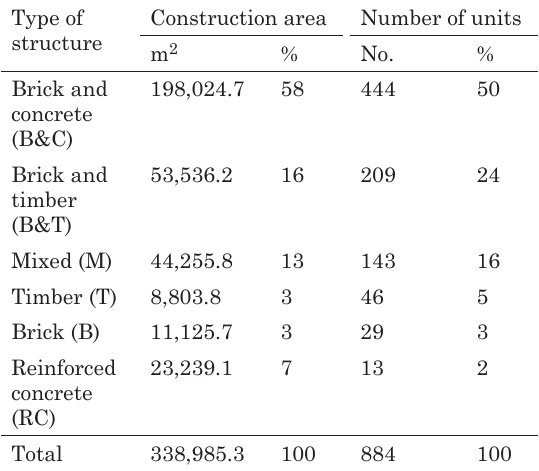
Table 1. Demolished buildings by structure type Type of structure